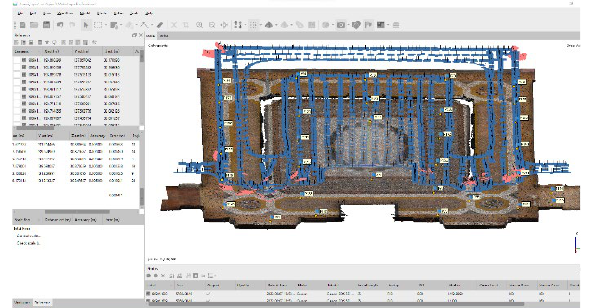
Figure 3 . The Sala degli Arazzi and its floor. This picture puts in evidence some obstacles for the survey: the presence of strong light from the window, the reflection of the pavement together with the obstacles present in the room and the decay of the floor